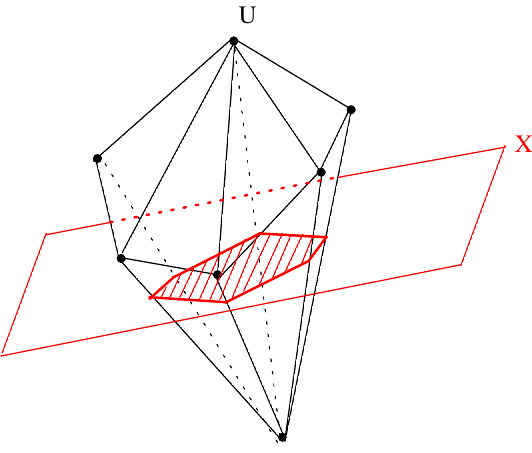
Figure 9 . A four-point function is consistent if it lies on the intersection between the crossing plane X [(cid:1) (cid:30) ] and the unitarity polytope U [